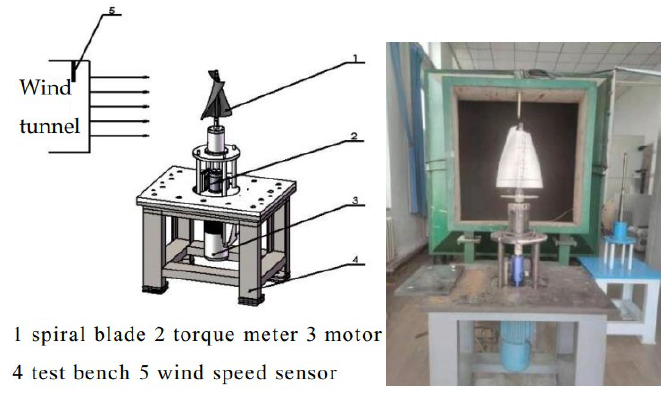
Figure 7. Structure diagram of spiral wind turbine test.